Question: Looking at the figure, what chart type is it?
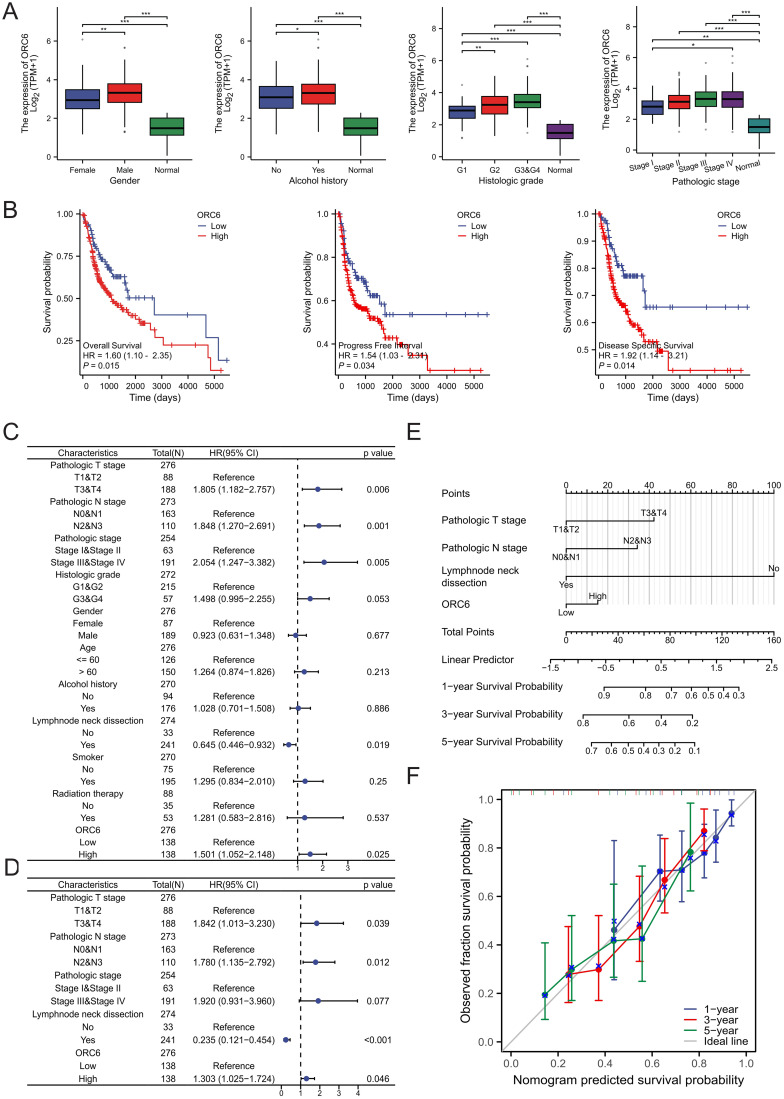
Answer: survival